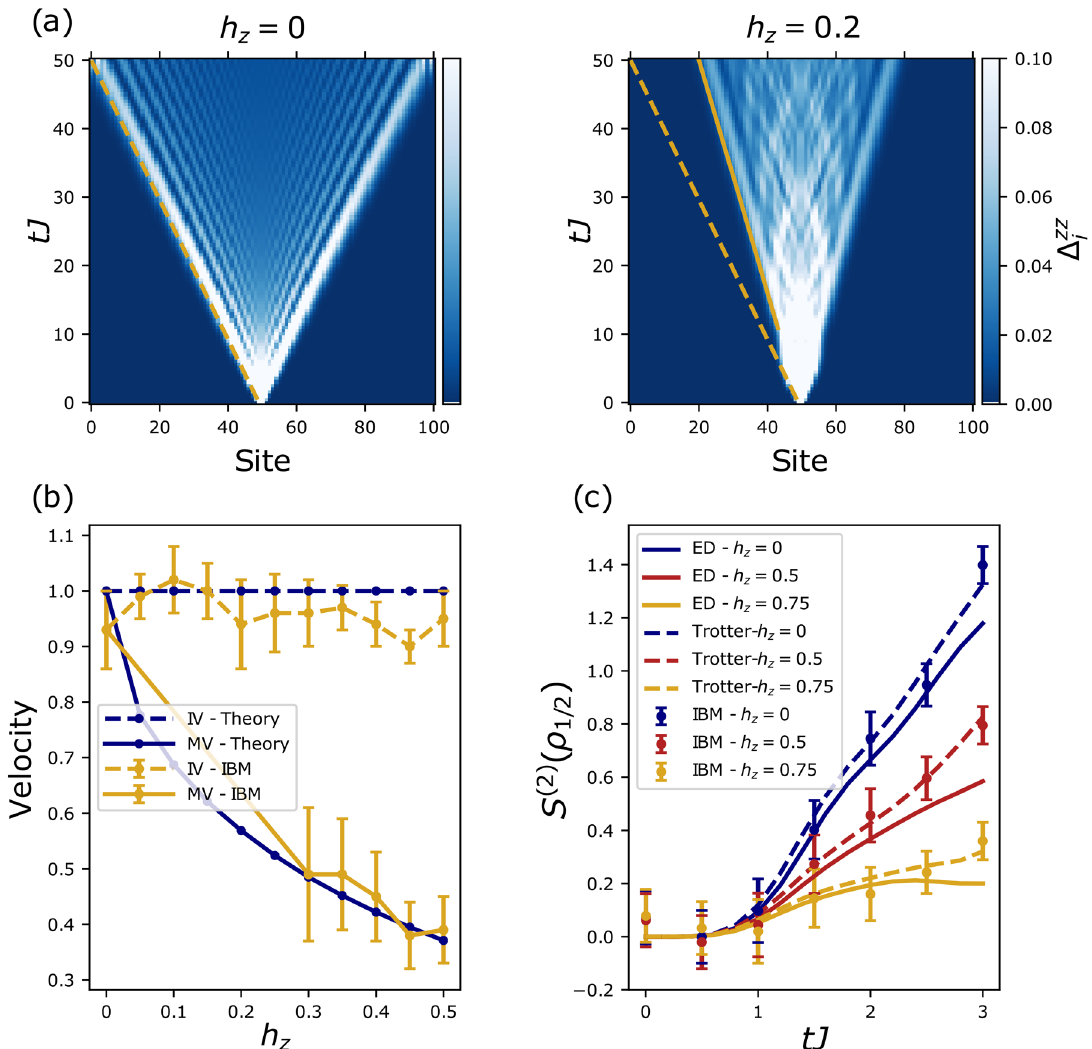
Figure 1. Velocities and entanglement Renyi entropy from the IBM device. (a) Real time dynamics of domain wall positions within the two kink subspace following a quantum quench to the TFIM without and with additional longitudinal field h z . These results are calculated via exact diagonalisation of the two kink subspace. Here, L = 101 , h x = 0.5 and the initial state is ferromagnetic with a single flipped spin in the centre. For h z = 0 the light cone structure of free particles is visible. For the confining case h z = 0 two velocities are observable, an initial velocity (dashed) equal to the free case and the meson velocity (solid) at longer times. (b) Comparisons of the two velocities, the initial velocity (IV) and meson velocity (MV), as measured on the IBM quantum computer ( h x = 0.5 and L = 9 ) after error mitigation and as theoretically predicted. Error bars displayed are the standard deviation of a range of velocities obtained, more details are given in the Supplementary Material. (c) Data from randomized measurements for the half chain second order Rényi entropy after a global quantum L − 1, 2 � for h x = 0.5 , L = 6 . The quench to the TFIM with varying a longitudinal field strengths on the state | 2 ballistic entanglement growth of the free case is suppressed because of confinement for increasing longitudinal field. Here, error bars are calculated by jacknife resampling. The inherent error in the IBM device leads to offset which has been removed, see the Supplementary Material for